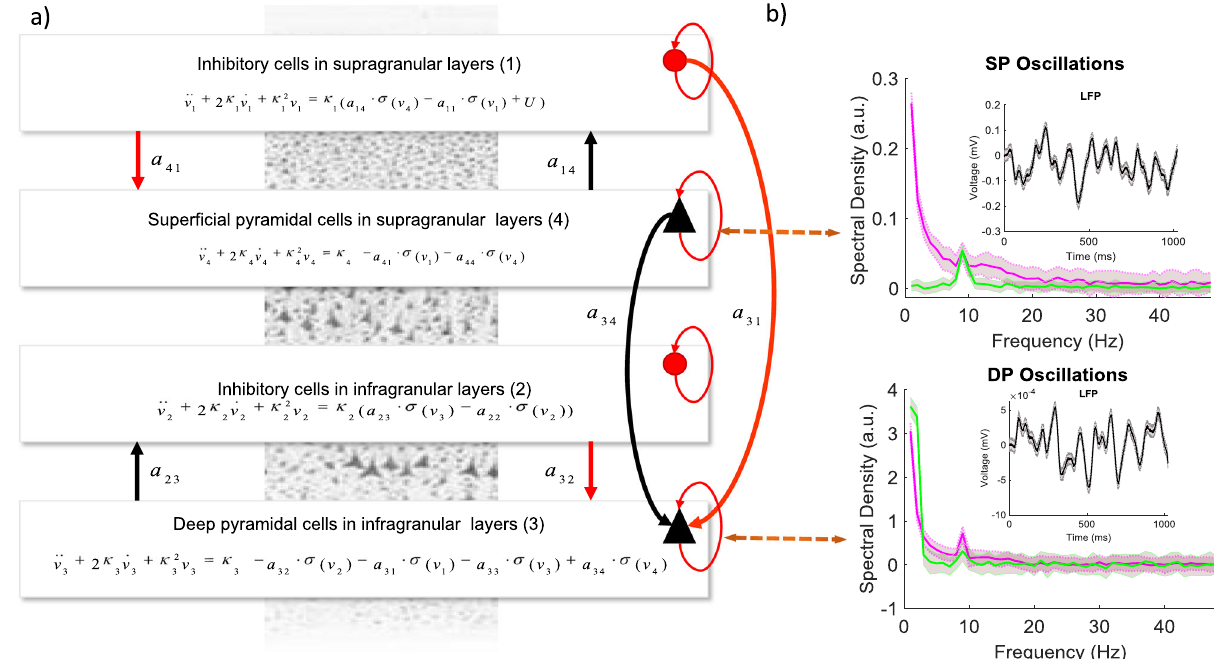
Fig. 1 Model and predictions. a Two pairs of excitatory (black) and inhibitory (red) populations occupy super fi cial and deep cortical layers. Firing rates within each population provide inputs to other populations and convolution of presynaptic activity produces postsynaptic depolarization. Arrows denote excitatory and inhibitory connections. All recurrent connections are inhibitory to preclude run-away excitation in the network. The same microcircuit was implemented both as a neural mass 11 and a compartmental model 5 . The equations describe the evolution of hidden states corresponding to activity in each of the four populations in the neural mass model. b Both models predict LFPs and power spectra. The top plot shows predicted power spectra from both models generated by super fi cial pyramidal neurons. Predictions from the neural mass model are shown in magenta, while predictions from the compartmental model are shown in green together with 95% con fi dence intervals. The bottom plot shows the same results for predicted spectra from deep pyramidal neurons. Insets in the top right corner of both plots show predicted LFPs. Note the peaked responses at 10 Hz that are reminiscent of spiking burst input that are also captured by the neural mass model